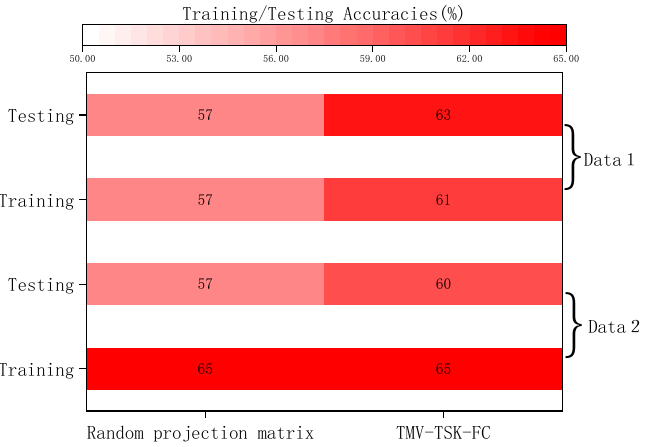
Figure 8. Comparison between TMV-TSK-FC and different feature optimization methods.